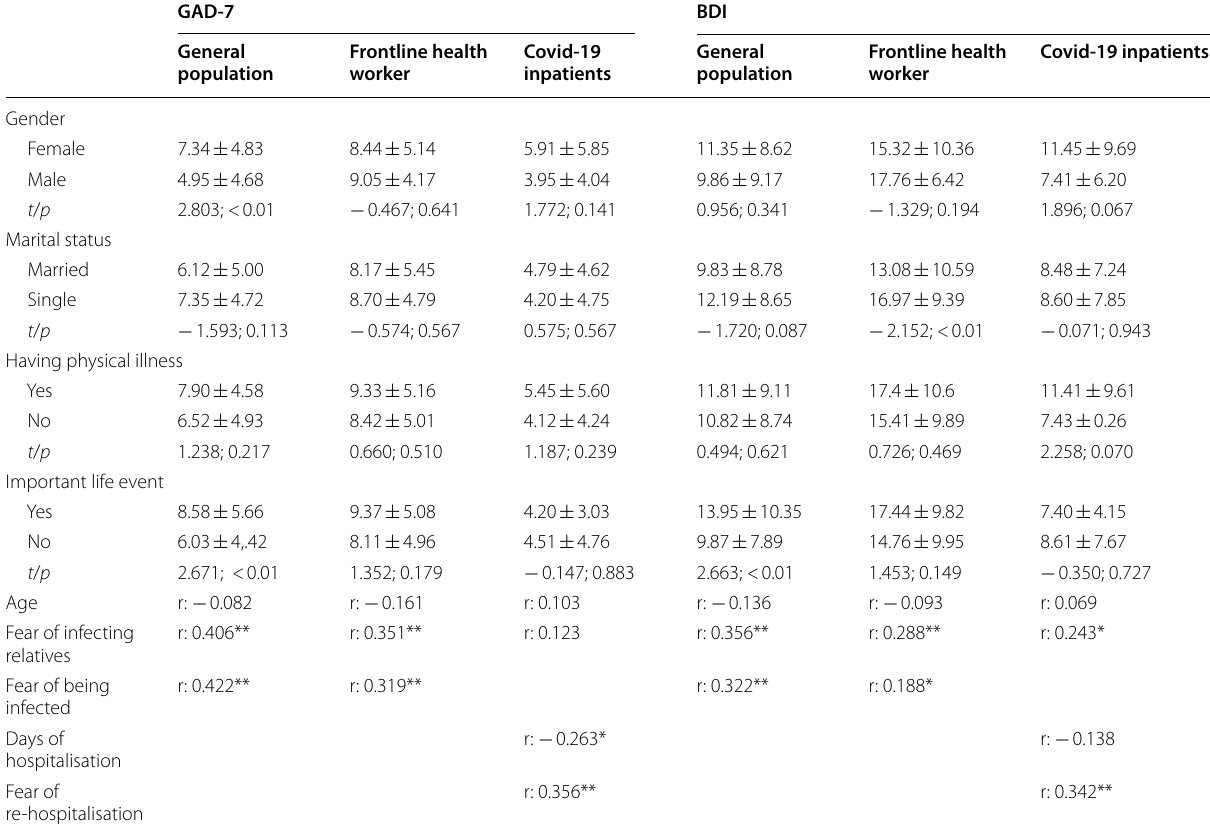
Table 3 The comparison and relationship of BDI, GAD‑7 with individual characteristics of